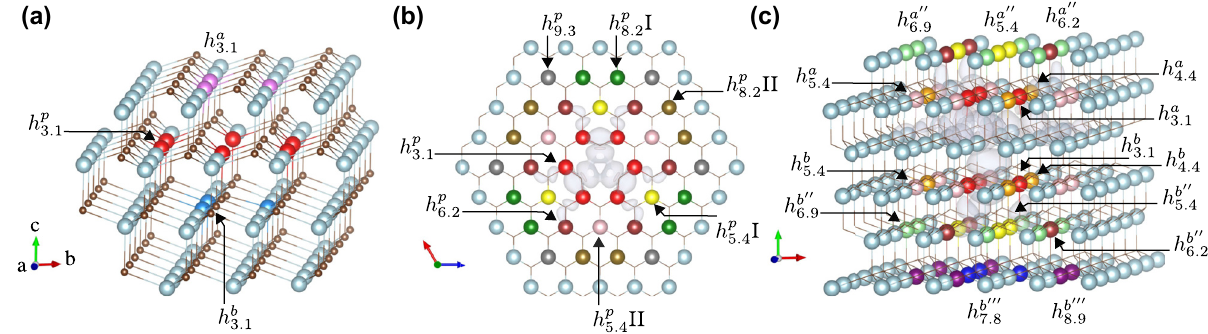
Figure 1: Possible sites of the carbon antisites for the h silicon vacancy. The silicon atoms are colored grey and the carbons are colored symmetry are colored with the same color in each subplot. The grey isosurface is the silicon vacancy spin brown. The equivalent atoms in C 3 𝑣 density. (a) The three symmetrically non-equivalent locations of the carbon antisite for the three closest configurations: h a (red) and h b (blue); (b) a top view of the non-equivalent locations of the carbon antisite in the plane ( p ) with the silicon vacancy; (c) the 3 . 1 layers above ( a ) and below ( b ) of the silicon vacancy. Additional layers above and below are denoted by primes (’) to indicate the layer distance. The color scheme is retained in subsequent plots to denote the distance between carbon antisite and silicon vacancy.